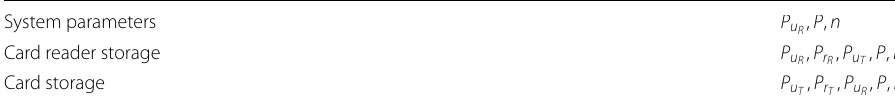
Table 2 System parameters Alamr scheme [3] System parameters P u Card reader